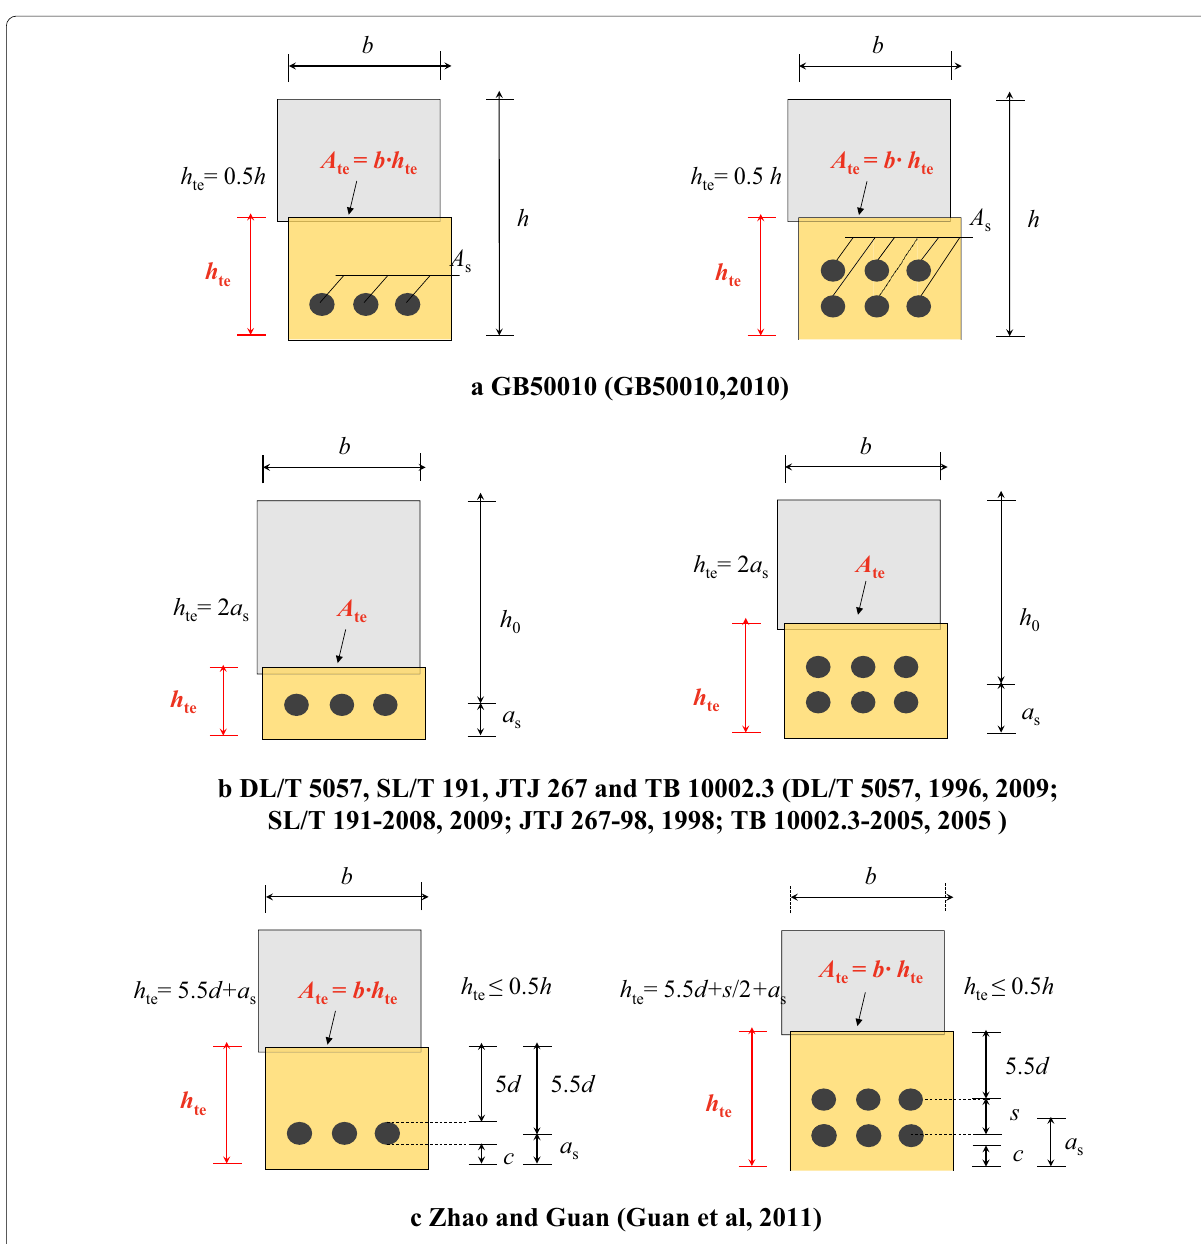
Fig. 8 The current three methods for determining A te (